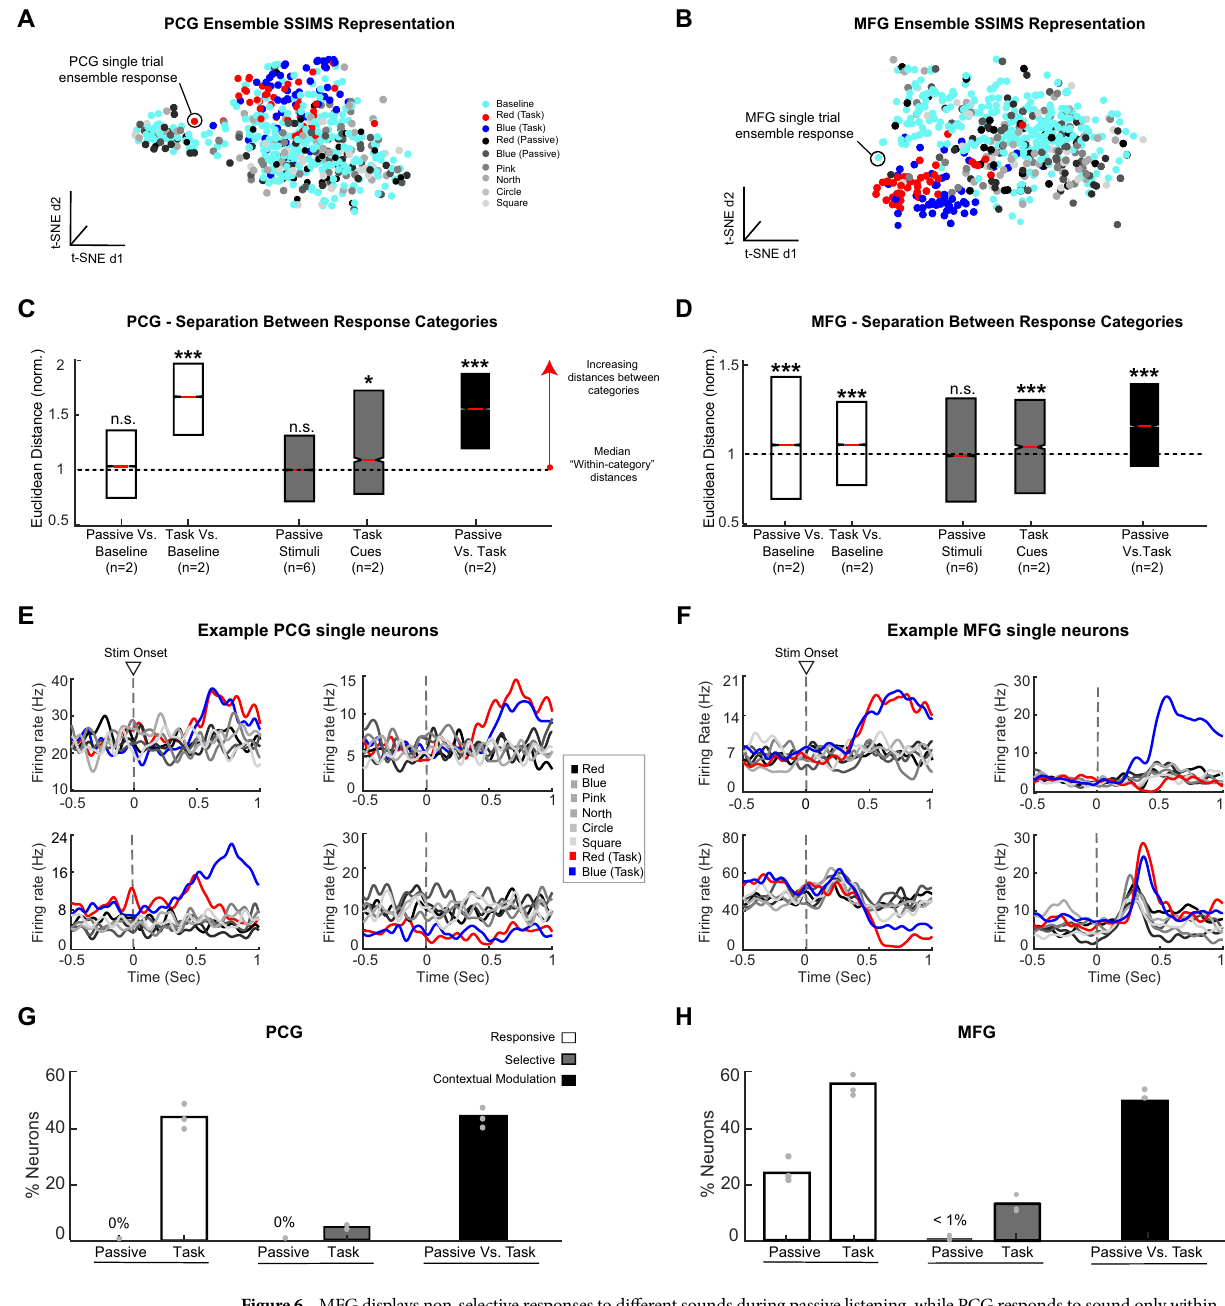
Figure 6. MFG displays non-selective responses to different sounds during passive listening, while PCG responds to sound only within the context of the behavioral tasks. ( A , B ) SSIMS representations of PCG ( A ) and MFG ( B ) ensemble responses (day 356) during the presentation of non-instructional auditory stimuli under a Passive Listening paradigm ( gray points ), the instructional auditory cues during the Multi-modal task ( red and dark blue points ), and a baseline period ( cyan point s). The proximity of the points reflects the similarity of the ensemble responses on those trials. ( C,D ) Boxplots show the degree of separation (median Euclidean distance) between different categories of trials (i.e., points) in the PCG ( C ) and MFG ( D ) SSIMS plots, for the following categories: between the baseline responses and non-instructional auditory stimuli ( Passive; white box ); the baseline responses and instructional auditory cues ( Task; white box ); among the six different sounds during the Passive Listening context ( gray box ); among the two different sounds during the Multi-modal task ( gray box ); and responses to sounds across the two different listening contexts ( black box ; context-dependent encoding of sounds). A KW test was used to assess significance among the distribution of “Between-category” and “within-category” distances (***, p < 0.001; *, p < 0.01; n.s. = not significant, p > = 0.05). See Methods and Fig. 2. for additional details. ( E,F ) Trial-averaged time-varying firing rates of four example PCG ( E ) and MFG ( F ) neurons to the non-instructional auditory stimuli ( gray solid lines ) and instructional auditory cues ( red/blue lines ). Dashed lines indicate stimulus onset timing. Note, example PCG neurons ( E ) only responded to the instructional auditory cues and not to any of those same auditory stimuli when presented in a non-instructional context (Passive Listening), while some MFG neurons ( F, bottom row ) were responsive to the non-instructional auditory stimuli (Passive Listening) but did not discriminate among the different auditory stimuli (Passive Listening). ( G , H ) Proportions of PCG and MFG neurons that were responsive ( white bars ) or selective ( gray bars ) for the instructional auditory cues (Passive) or non-instructional auditory stimuli (Task) and exhibited context-dependent encoding of the sounds across behavioral contexts ( black bar ). Gray dots represent the percentage of neurons for each session. This figure was compiled using MATLAB 2019, MathWorks software and labeled using Adobe Illustrator CC